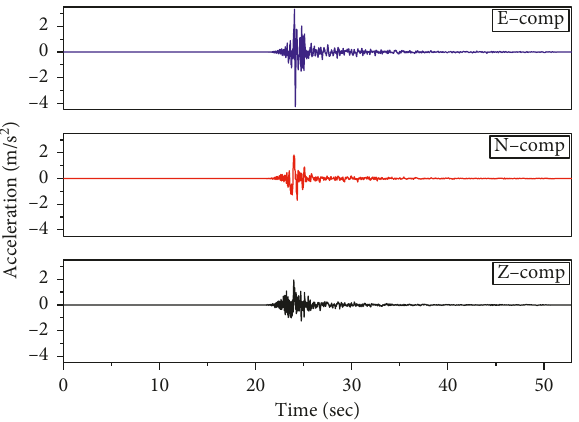
Figure 4: Acceleration history of Norcia Earthquake